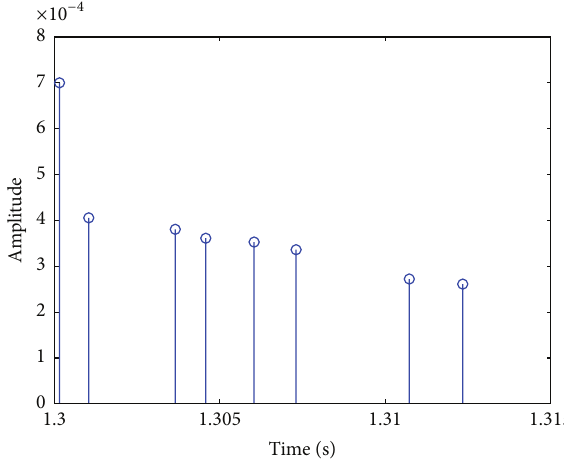
Figure 3: Simulation of channel impulse